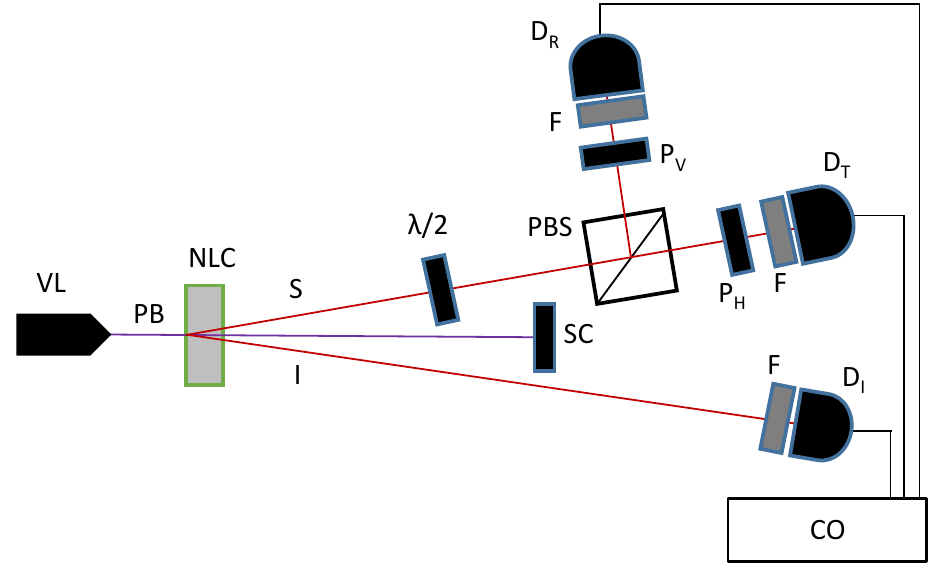
Figure 1. Experimental setup, where a pair of photons signal and idler (S, I) are produced when a non- linear crystal ( NLC ) BBO - I is pumping by a violet laser ( VL ), through spontaneous parametric down conversion process. Idler photons are sent to the idler single photons detector ( D I ). Signal photons are sent to a λ /2 wave plate followed by a PBS. In order to compensate for the polarizing beam splitter imperfections, we placed two polarizers with their horizontal and vertical axes on the transmitted and reflected outputs, respectively. Finally, interference filters( F ) for 810 nm were placed before the avalanche photodiodes ( D R , D T